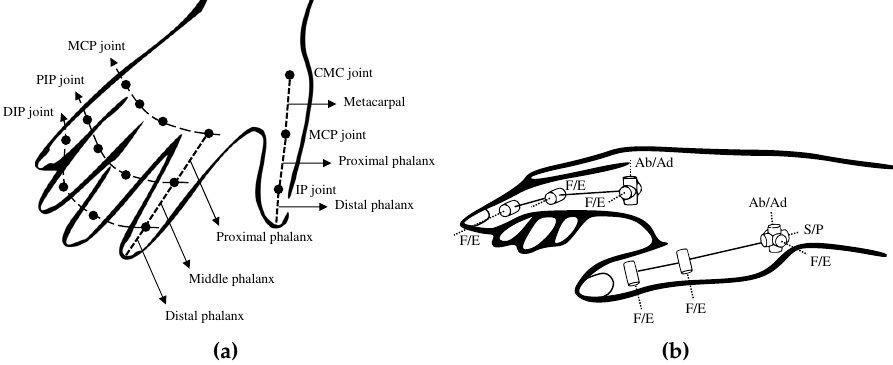
three finger joints: the metacarpophalangeal (MCP), proximal interphalangeal (PIP), and distal interphalangeal (DIP) joints. The MCP joint has two rotational DOFs: Flexion/extension (F/E) motion in the sagittal plane and abduction/adduction (Ab/Ad) motion in the transverse plane, as shown in Figure 1. The other joints have one rotation DOF of F/E motion. The active ranges of motion (active ROM) of the MCP, PIP, and DIP joints are − 19 ◦ ∼ 90 ◦ , − 7 ◦ ∼ 101 ◦ and − 6 ◦ ∼ 84 ◦ , respectively [19].